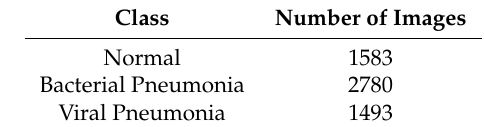
Table 2. Pneumonia dataset distribution.